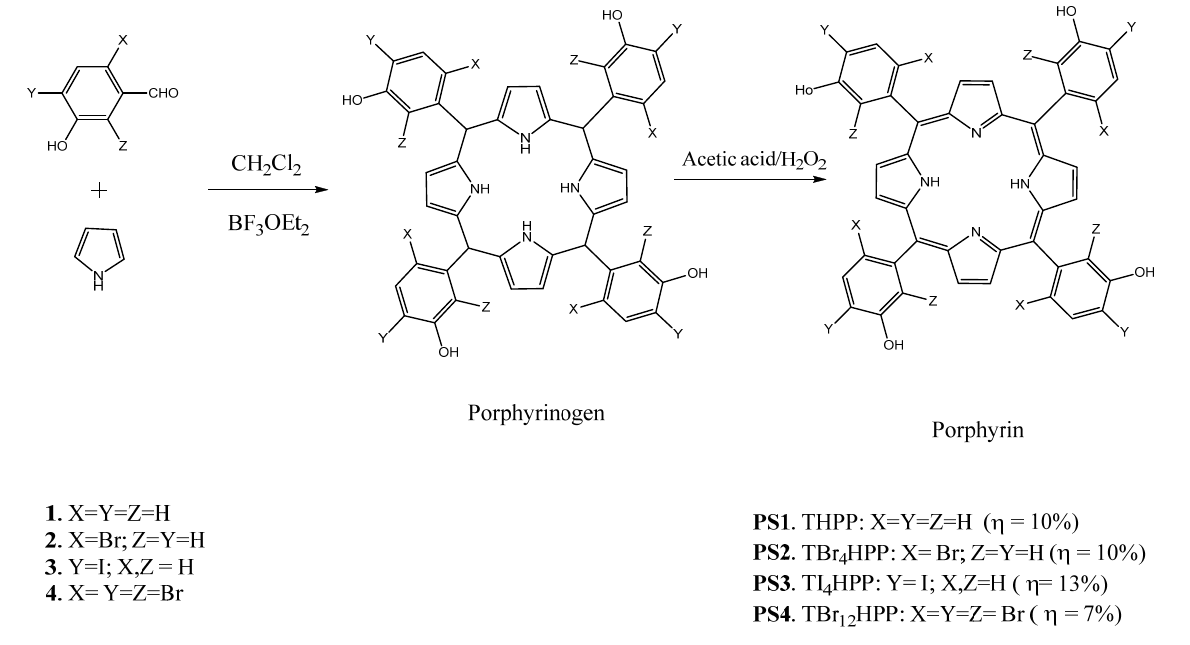
Figure 1. Synthesis of 5, 10, 15, 20-tetrakis(3-hydroxyphenyl)porphyrin derivatives PS1 – PS4 [48].